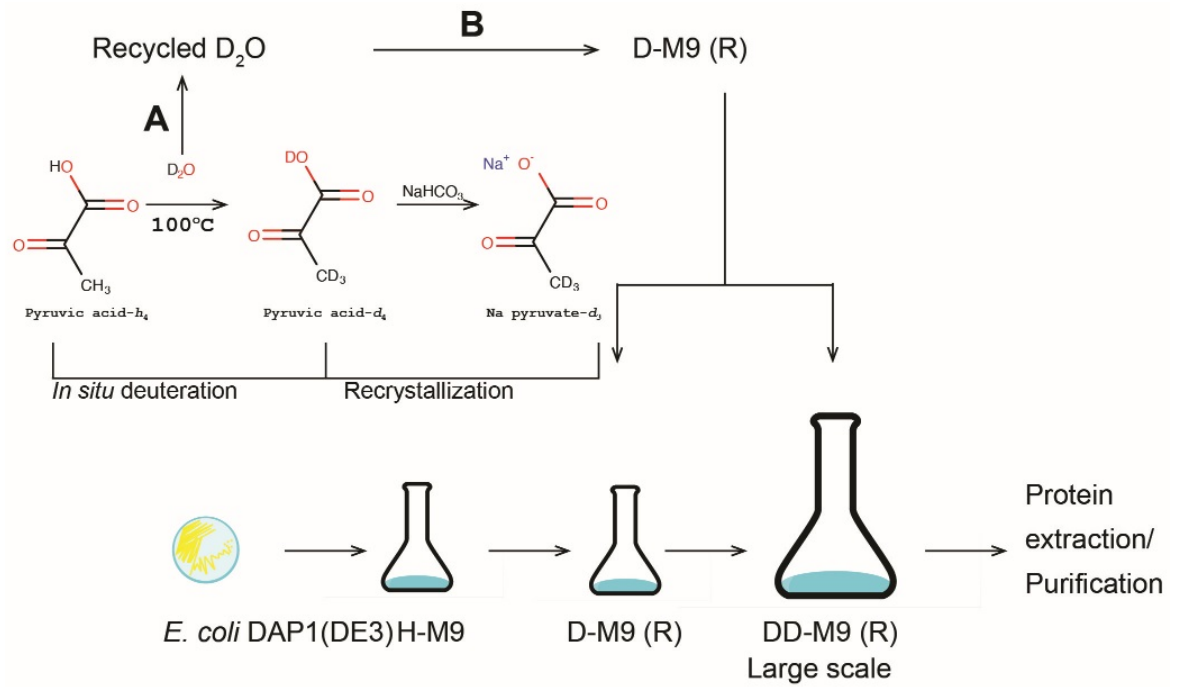
Figure 3. Framework of production of sodium pyruvate- d 3 , and deuteration of recombinant proteins. Deuterated pyruvic acid is produced by boiling pyruvic acid in D 2 O. This solution can be immediately used as base for growth medium or sodium pyruvate- d 3 can be recrystallized. The heavy water (D 2 O) used in pyruvate deuteration could be used for subsequent labelling procedures (A) or used as solvent for growth media (B).